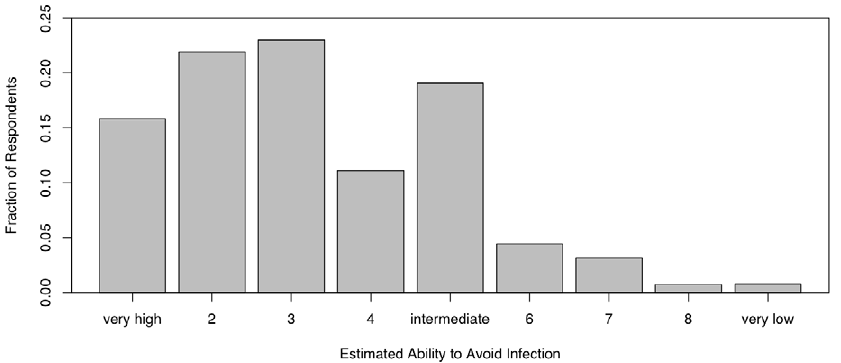
Figure 4. Frequency distribution of personal empowerment. Again, while most respondents list a high level of personal empowerment, there is a decided second mode at the intermediate level (1=‘‘very high: I feel confident I can avoid infection’’, 5=‘‘intermediate’’, 9=‘‘very low: I feel I will not be able to avoid infection’’).